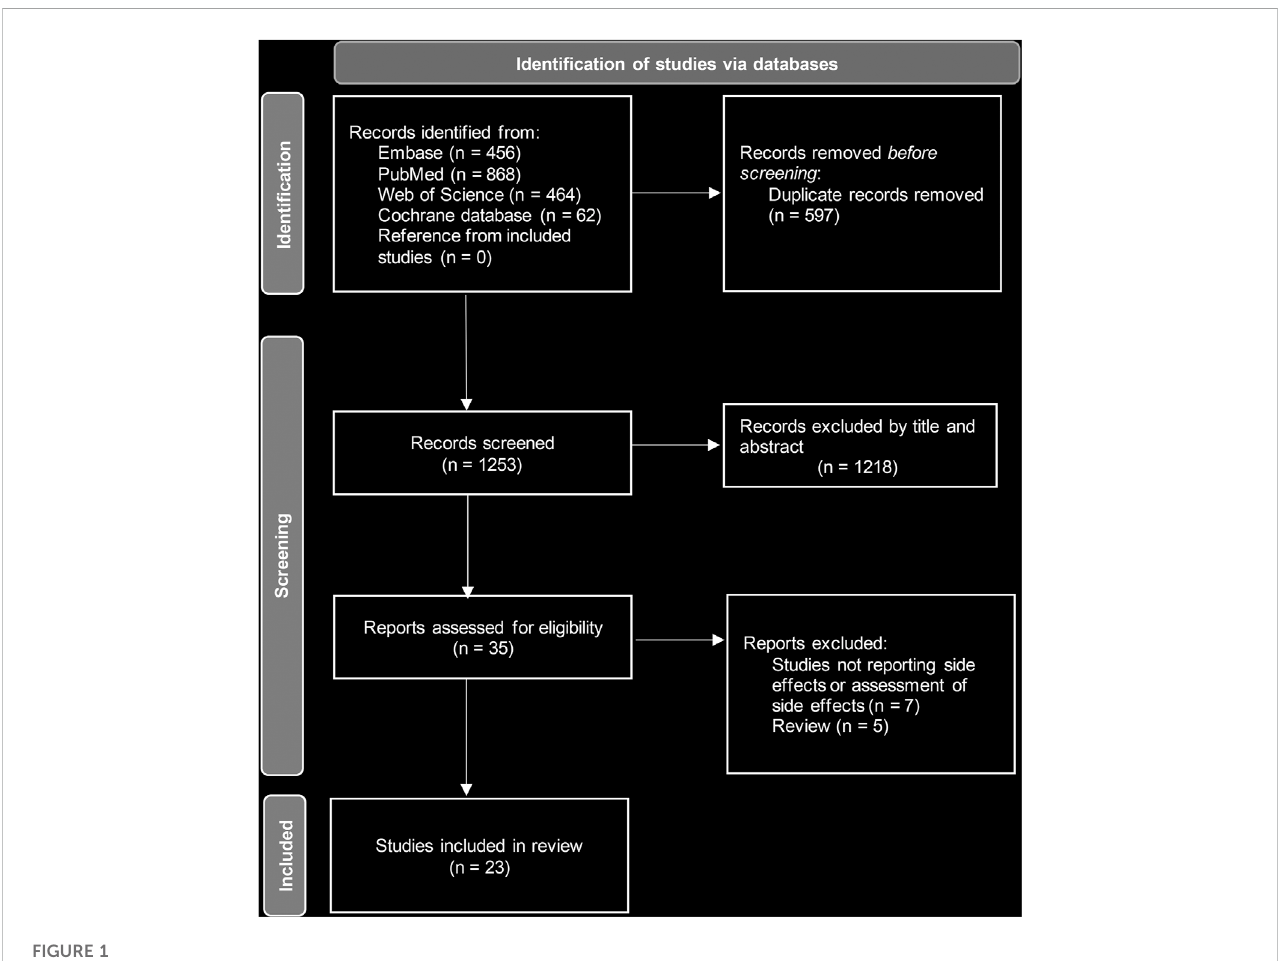
FIGURE 1 Flowchart of